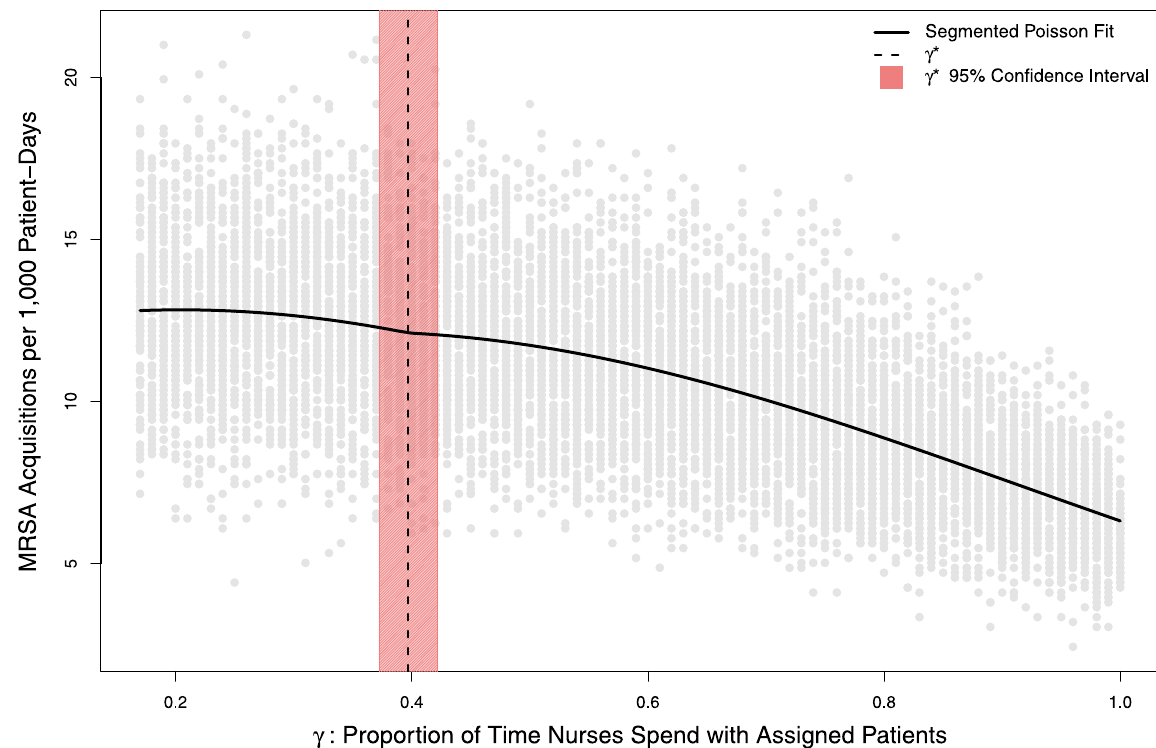
Fig 4. Relationship between the proportion of time nurses spend treating patients outside their assigned group ( γ ) and cumulative MRSA acquisitions over 10,000 simulations, randomly sampling γ from a uniform distribution between 1/6 and 1. Grey dots show an individual simulation, while the black line shows a segmented Poisson regression fit with linear and quadratic terms for γ . The vertical dashed line depicts the single segmentation point, γ � , to the left of which these more complicated models are adequately approximated by the Nurse-MD model where random mixing occurs. The shaded area shows the corresponding confidence